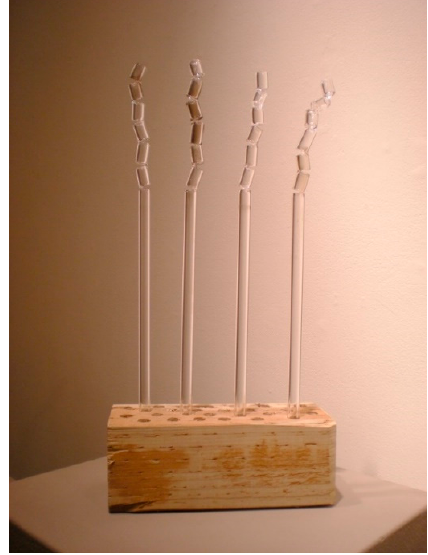
Figure 8. A test of tubing (2015) by Ayako Tani.